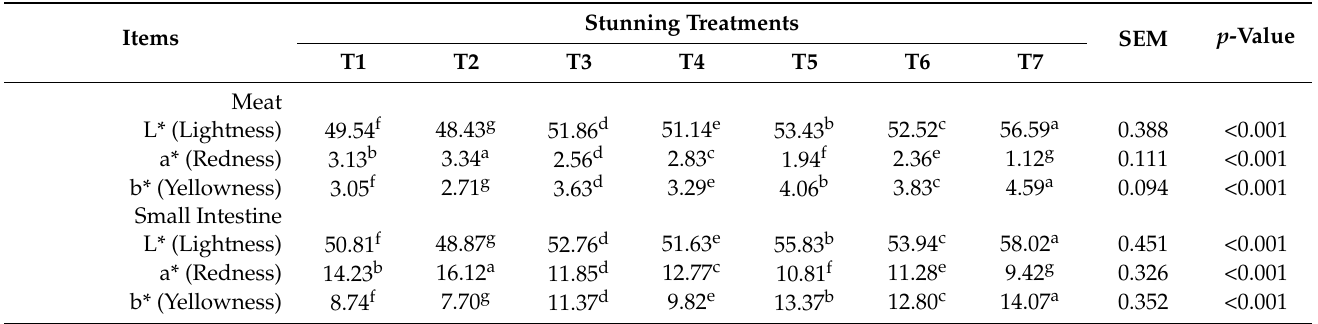
Table 3. Effect of high concentration levels of different gas stunning conditions on meat & small intestine of stunned rabbits (n=